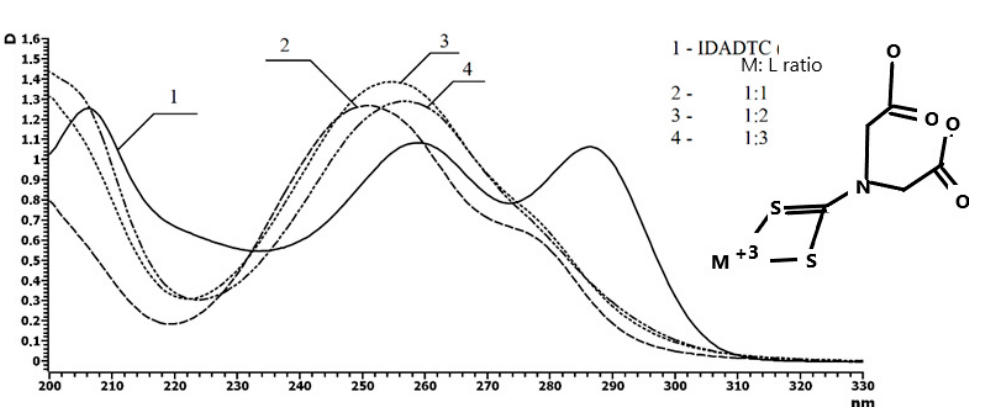
Figure 3. UV spectra of indium-iminodiacetic acid—dithiocarbamate (IDADTC) complexes of different stoichiometries. Concentration of IDADTC is 1 × 10 − 4 mol/L (water). In the 13 C NMR spectra of the complex with M:L ratio equal to 1:3, the following signals were observed: 202 ppm (CSS) (211 ppm: free ligand), 173 ppm (COO − ), 61 ppm (–CH 2 − ) (Figure 4). The 1 H NMR spectrum contained a singlet signal at 4.38 ppm, down field shifted in contrast to free ligand (4.62 ppm), assigned to two equivalent methylene groups of the ligand. This structure of NMR spectra indicates coordination between the ligand and indium ion.